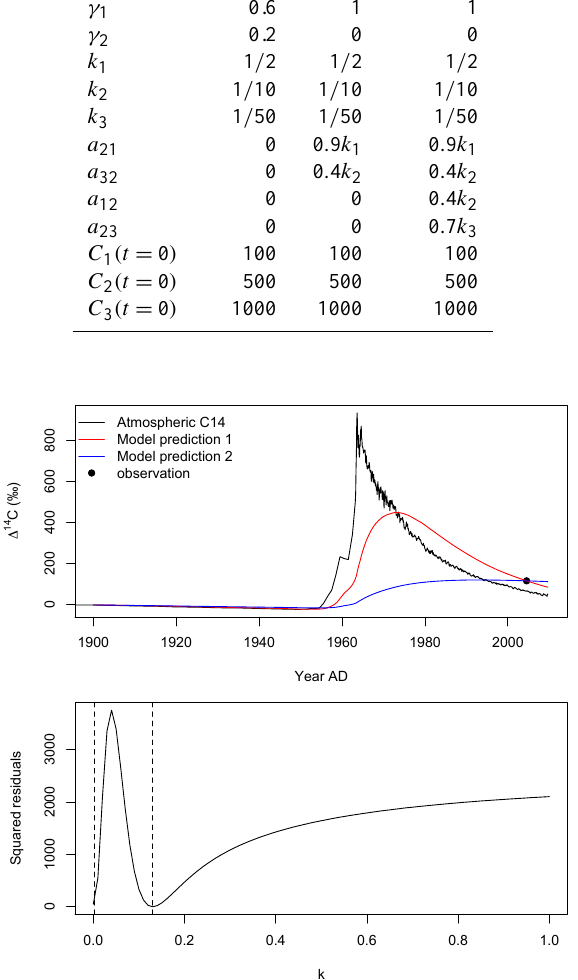
Figure 3. Output of the function turnoverFit for a radiocar- bon sample taken at a temperate forest soil subject to annual inputs of 473Mg C ha − 1 yr − 1 . The upper panel shows the two possible curves that can match the observed radiocarbon value. The bottom curve shows the squared residuals between predictions and obser- vations for different values of k in a one pool model. See documen- tation of function turnoverFit for additional details.